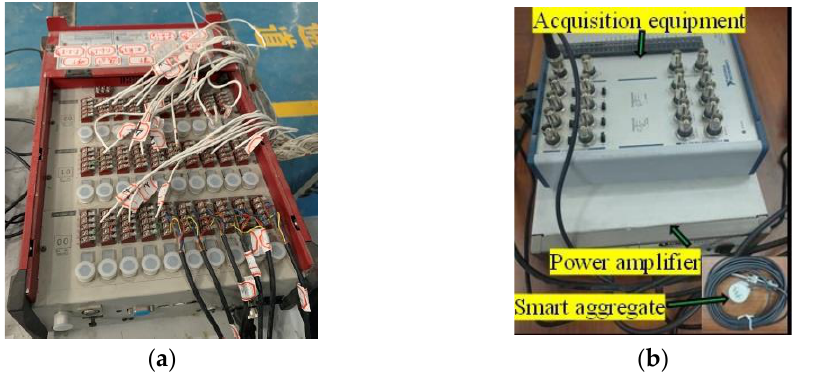
Figure 8. Test instrumentation. ( a ) The instrumentation for the strain gauges and LVDTs; ( b ) The instrumentation for SA transducers.